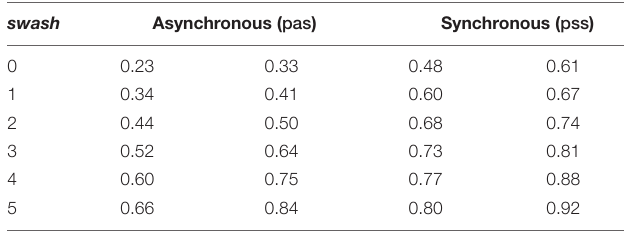
TABLE 3 | Summaries of the posterior distributions of the proprioceptive drift model showing the means, standard deviations, and 95% credible intervals.